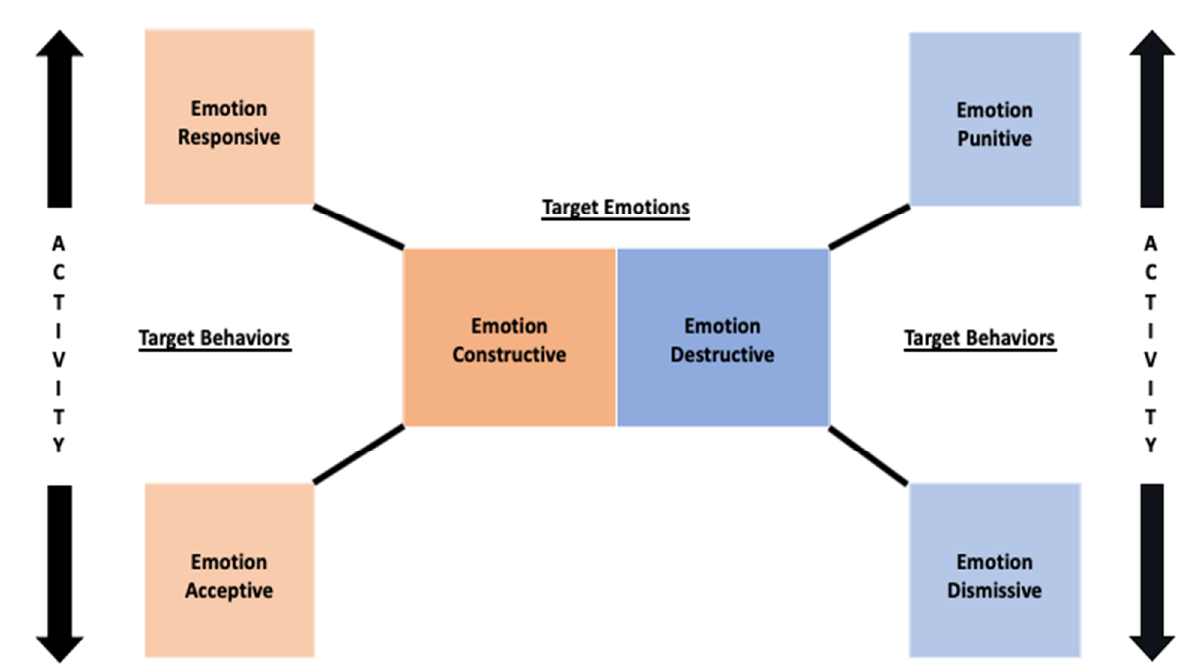
Figure 1. Parent and Peer Emotion Responsivity Styles. The central responsivity styles of Emotion Constructive (positive) and Emotion Destructive (negative) are employed to target emotions directly, while the outer styles target emotion-related behavior with varying levels of activity, with Emotion Responsive (positive) and Emotion Punitive (negative) featuring higher activity, and Emotion Acceptive (positive) and Emotion Dismissive (negative) utilizing less parental/peer activity.